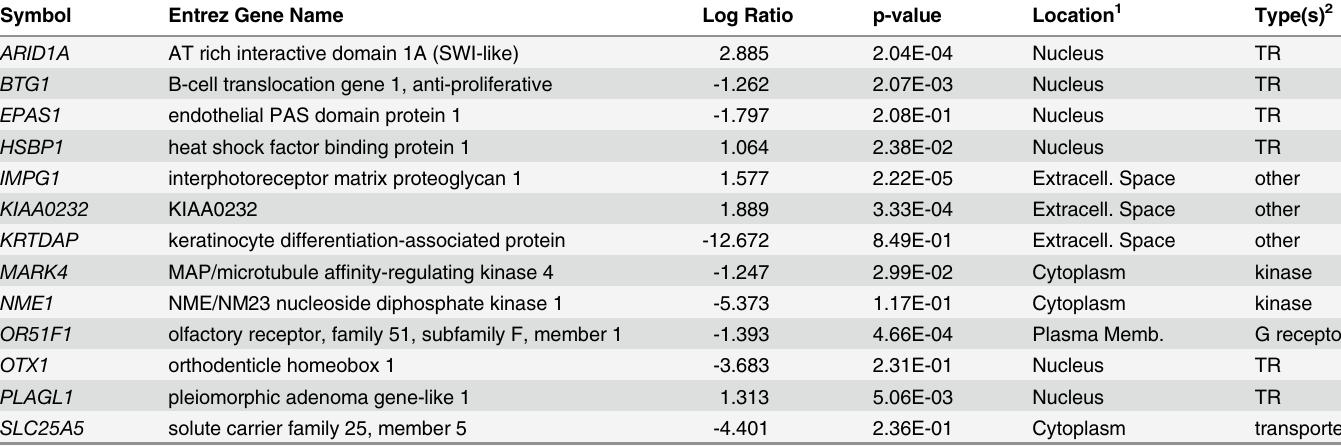
Table 4. Symbol, entrez gene ID, log ratio expression value, type of molecule and localization in the cell for the 13 differentially expressed genes affected by the weaning × diet × time interaction. Symbol